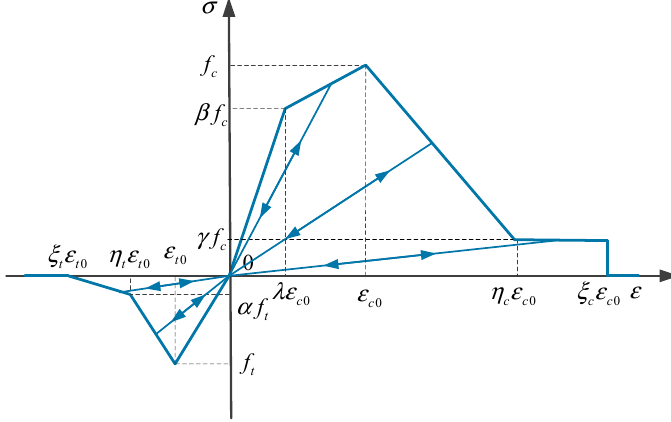
Figure 6. Mechanical constitutive model of materials. Table 1. Mechanical parameters of materials.